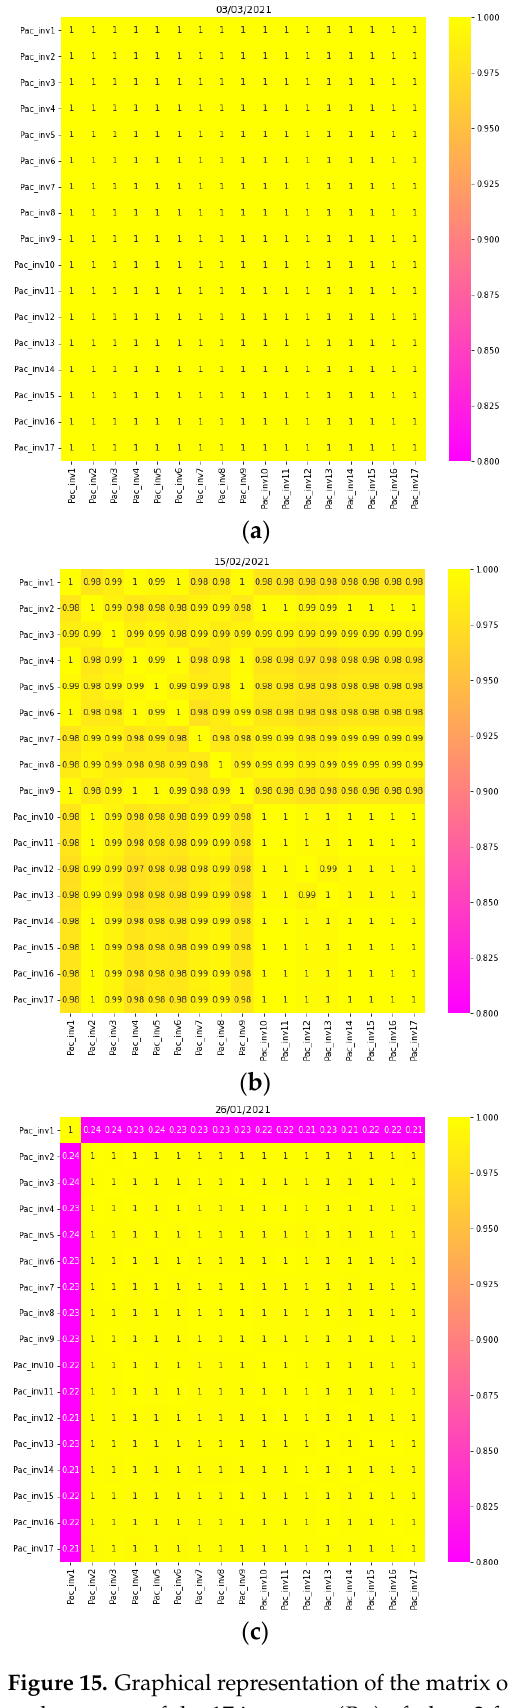
( b ) Figure 14. P ac corresponding to inverters 1 and 2 of plant 1 on 15 February 2021 ( a ) and 26 January 2021 ( b ). The correlation index matrix representation is even more useful in the case of instal- lations where the number of inverters is higher, as in the case of plant 2. As an example, the representation of the correlation index matrices for the 17 inverters in the plant for three different days (3 March 2021 ( a ), 15 February 2021 ( b ) and 26 January 2021 ( c )) is shown in Figure 13. In Figure 15, it can be seen that, for 3 March 2021, the production of the 17 inverters is perfectly correlated, since the correlation indices all have the value of 1. This means that all 17 inverters in the plant are producing at the same rate, as shown in Figure 16, where the P ac power produced that day by the 17 inverters is shown (Figure 16a,b). If we look at the correlation index matrix for the day 15 February 2021 (Figure 15b), we find that there are small deviations in the production of some inverters, but none of them are very sig- nificant. The colour variations of the representation also highlight these small deviations. This behaviour corresponds to the P ac production of the 17 inverters shown for that day in Figure 16c,d. There are small deviations in the production, which result in the Pearson correlation index values of some inverters not having the unity value, but these are very